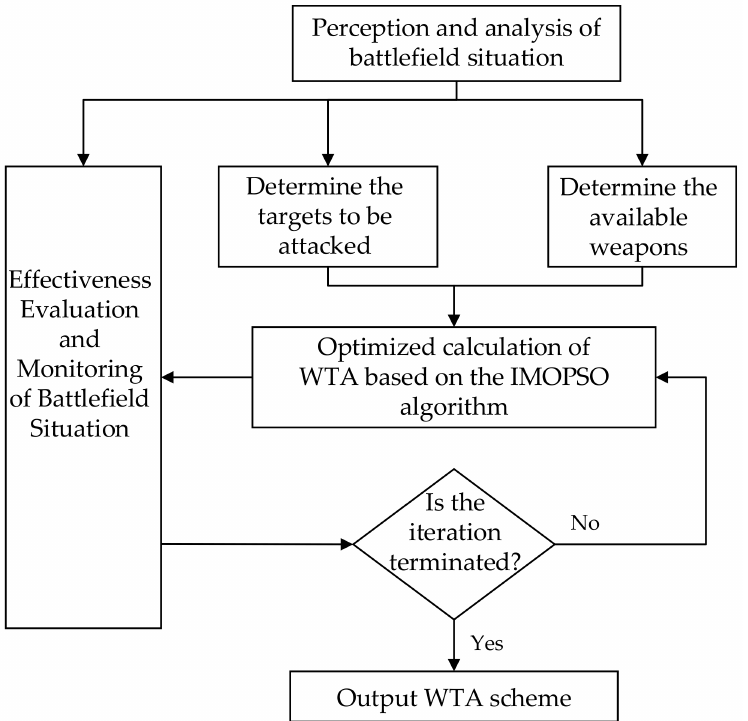
Figure 3. Decision-making process of DWTA problem.